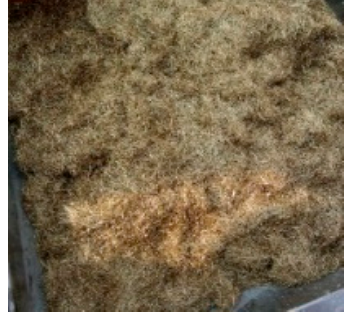
Figure A1. Steel fiber in concrete.